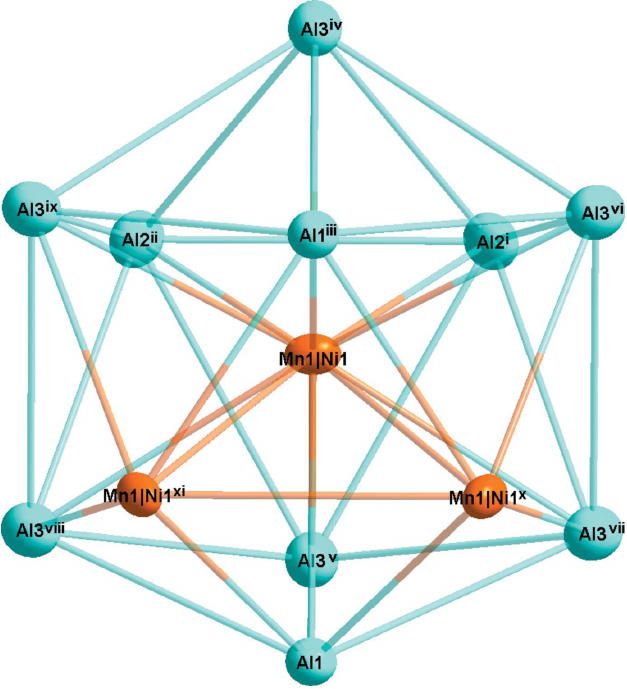
Figure 2 The environment of the (Mn1/Ni1) site. Displacement ellipsoids are given at the 90% probability level. [Symmetry codes: (i) (cid:3) x + y , (cid:3) x + 1, z ; (ii) Figure 3 (cid:3) y + 1, x (cid:3) y + 1, z ; (iii) (cid:3) x , (cid:3) y , z + 1 ; (iv) x , y , (cid:3) z + 3 ; (v) x , y , z (cid:3) 1; (vi) 2 2 y , (cid:3) x + y , z (cid:3) 1 ; (vii) y , (cid:3) x + y , (cid:3) z + 1; (viii) x (cid:3) y , x , (cid:3) z + 1; (ix) x (cid:3) y , x , The fusion of five polyhedra centered at one (Mn1/Ni1), two Al1 and two 2 z (cid:3) 1 Al2 sites. ; ( x ) (cid:3) x + y , (cid:3) x , z ; (xi) (cid:3) y , x (cid:3) y , z .] 2